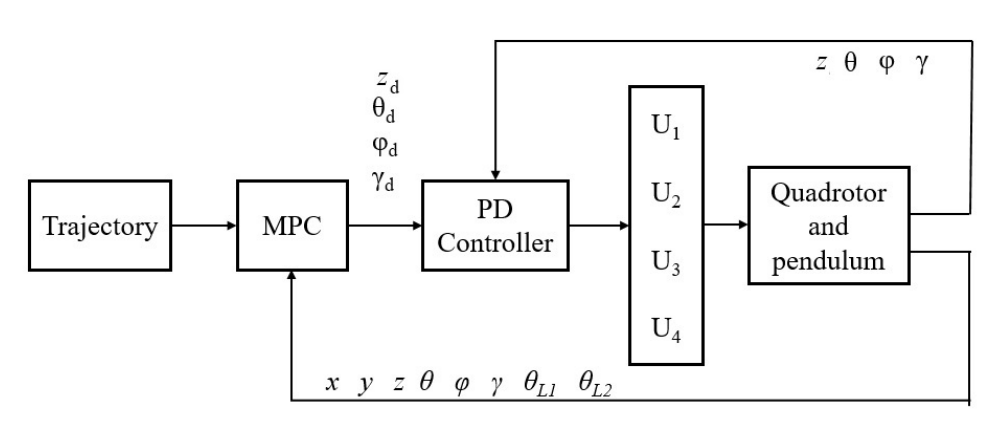
Figure 3. MPC-PD Control Configuration of the